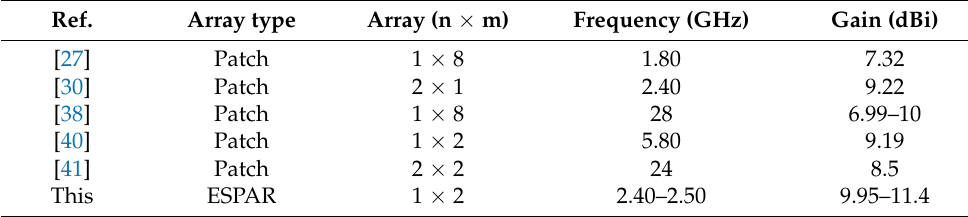
Table 5. Comparative analysis of the proposed array antennas.